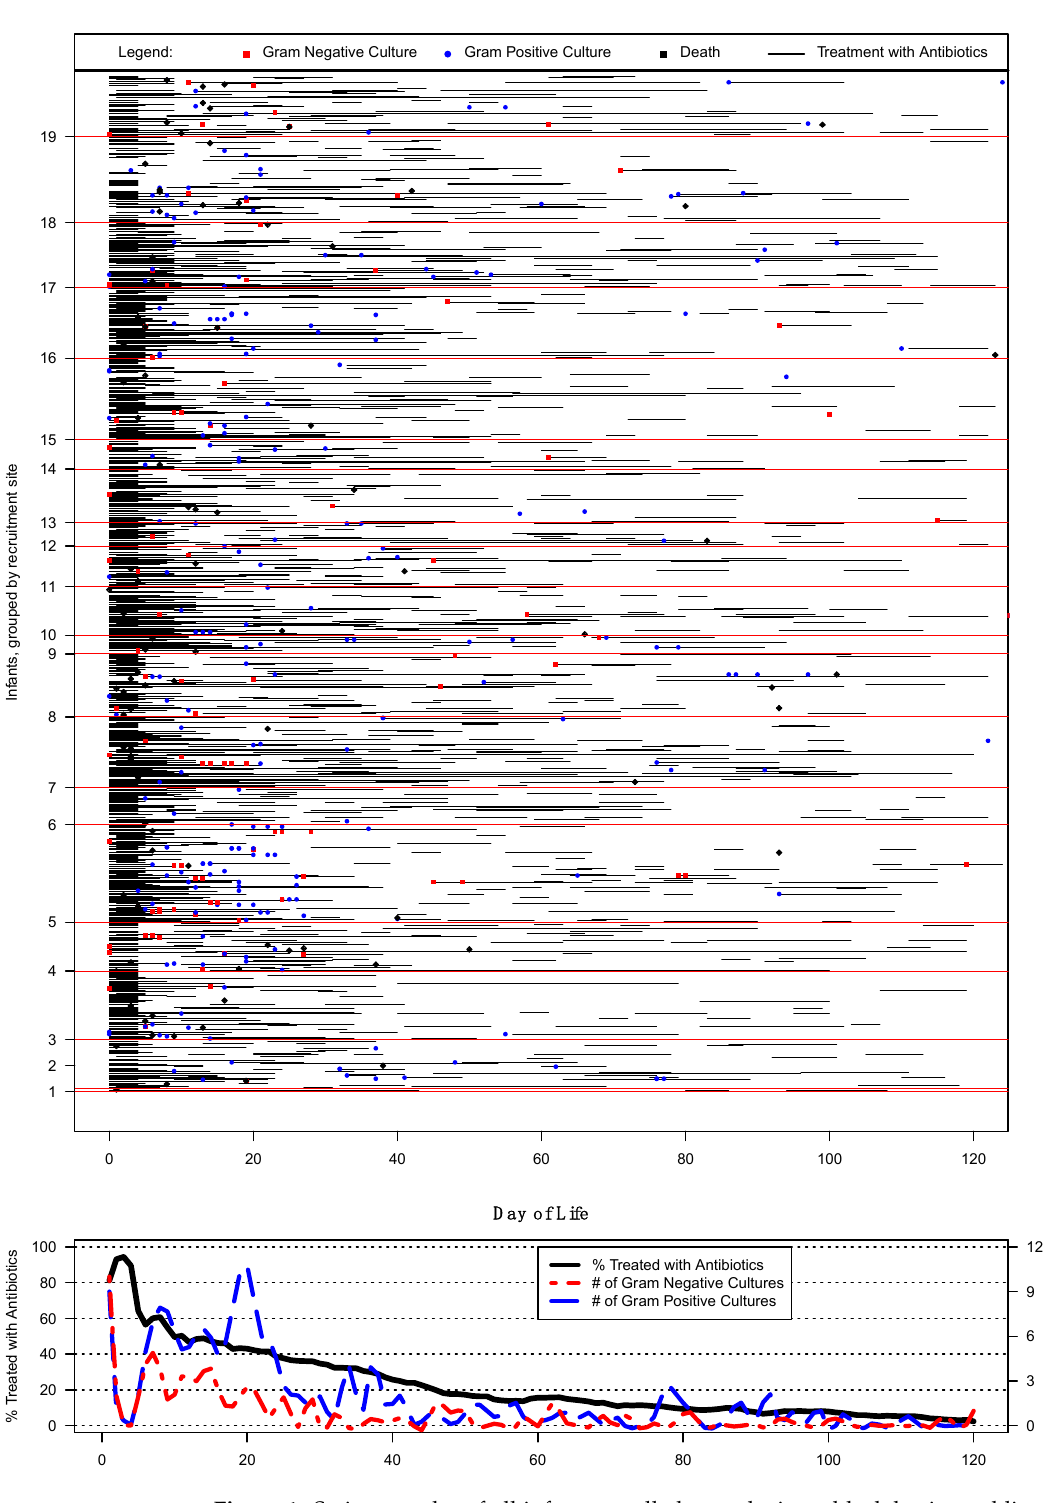
Figure 1. Swimmer plot of all infants enrolled at each site; a black horizontal line represents one antibiotic treatment course (with length of treatment represented by the length of the horizontal line) by days of life along the x-axis. Colors and symbols denote the status of a positive blood culture or death according to the figure legend embedded